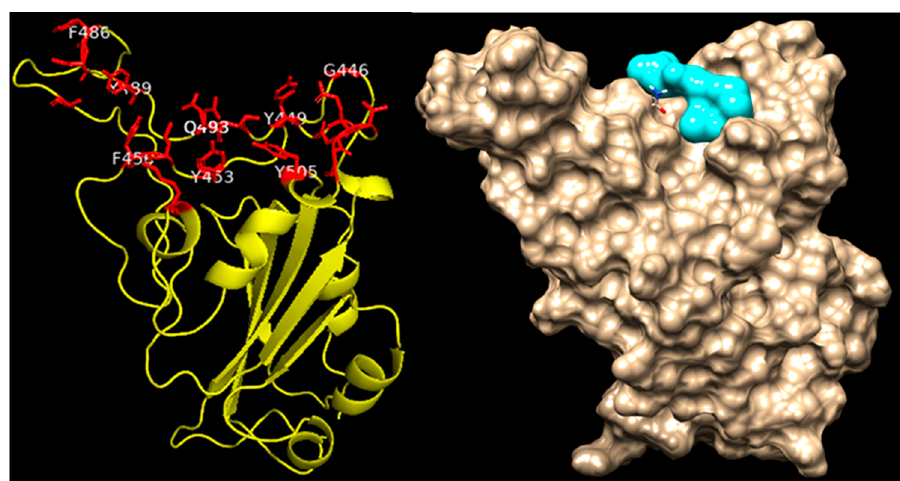
Figure 4. Structure of Spike protein of SARS-CoV-2 virus. The receptor binding domain (RBD) of the Spike protein is indicated in red color stick/blue.